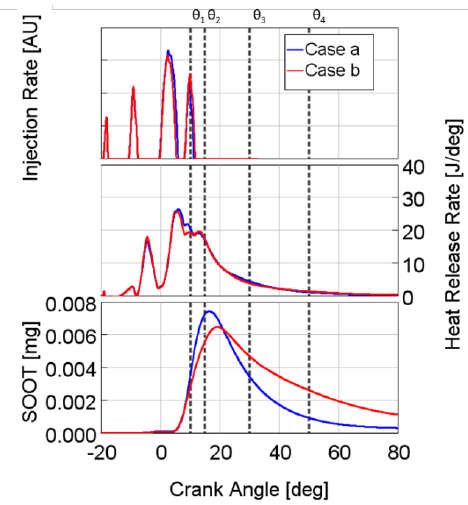
Figure 18. Numerical results for the injection rate (top), heat release rate (center) and the total soot mass (bottom), red lines for case (a) (ET = 170 µ s) and blue lines for case (b) (ET = 210 µ s) of the post injection test matrix of Figure 14.